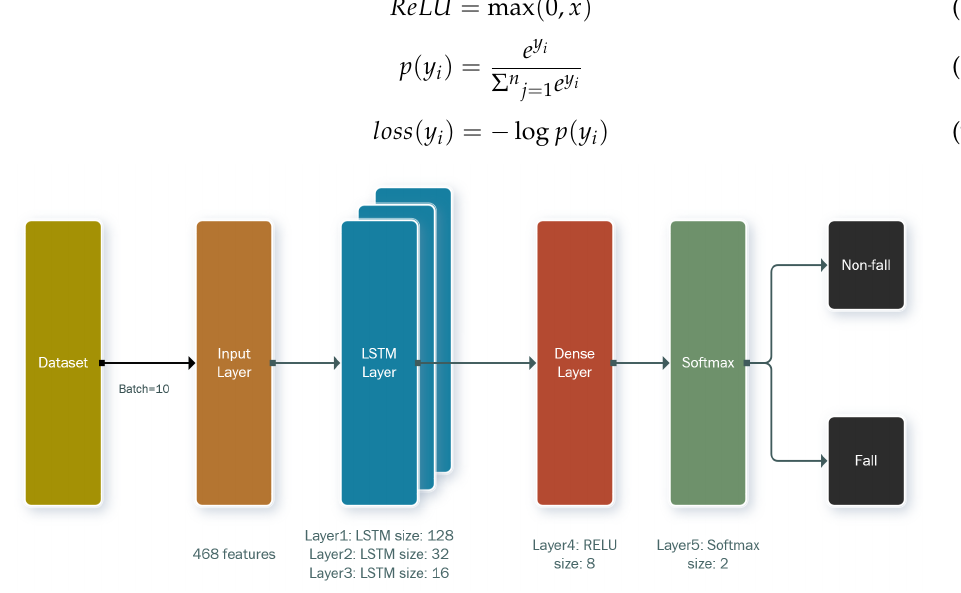
Figure 12. LSTM network